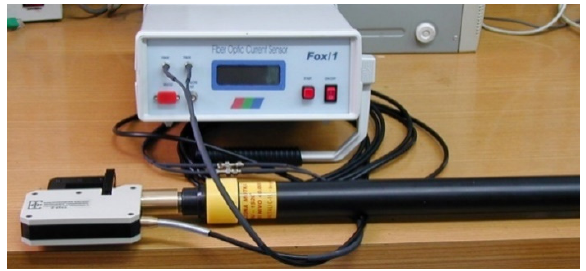
Figure 1. Portable OCT with measurement head mounted on an insulating rod certified to operate up to 100 kV.